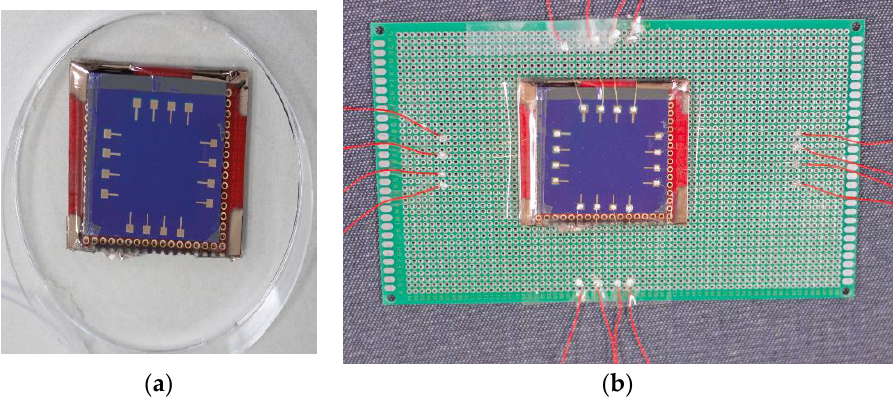
Figure 5. Graphene sample that is used in experimental studies for the conductivity profile. ( a ) copper electrodes coated on graphene surface ( b ) gold wires are used to connect the copper electrodes with copper wire terminals for EIT measurement setup.